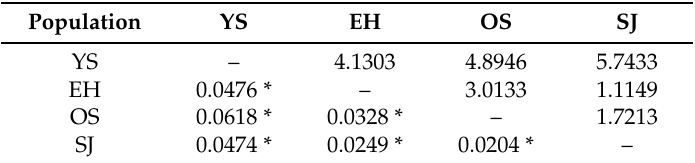
Table 2. Pairwise F st (below diagonal) and ( δμ ) 2 distance (above diagonal) among populations of Pacific cod.